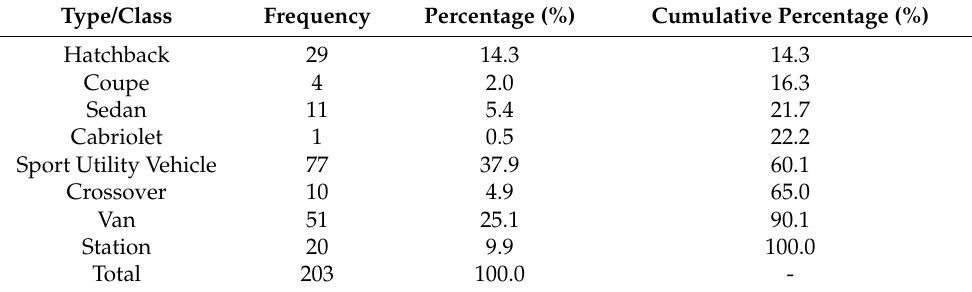
Table 2. Types (class) of electric vehicle considered.